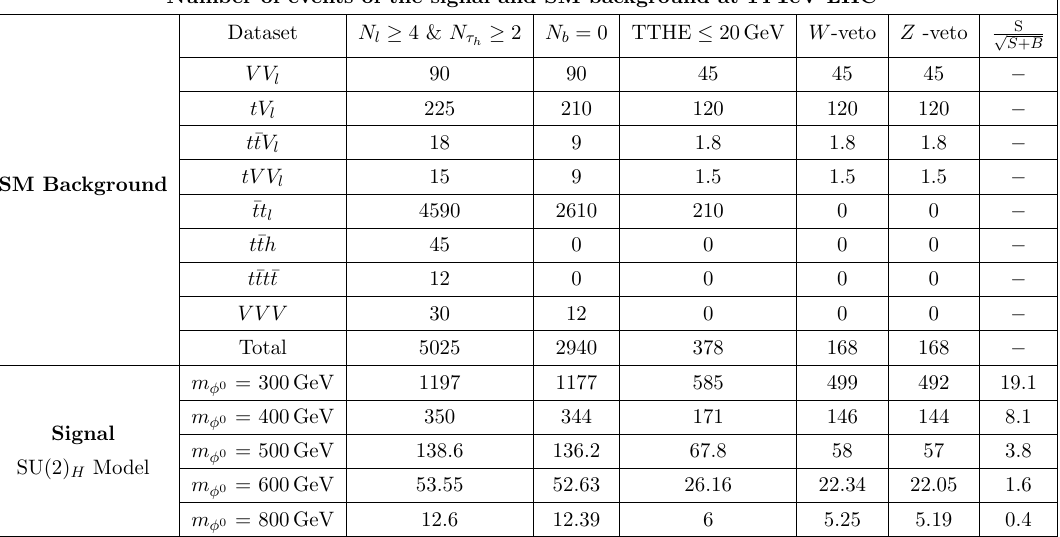
Table 1 . Collider analysis of the signal pp ! l + l (cid:0) (cid:28) + (cid:28) (cid:0) in SU(2) H model. The expected number of signal events and SM background are presented, together with the e(cid:11)ect of a set of acceptance p cuts, for LHC center-of-mass energy s = 14 TeV with integrated luminosity L = 300 fb (cid:0) 1 . The index V denotes the SM gauge bosons and subscript l in the dataset indicates leptonic decay of gauge bosons and top quarks. Signal events for (cid:12)ve di(cid:11)erent masses m = 300, 400, 500, 600 and (cid:30) 0 i 800 GeV are